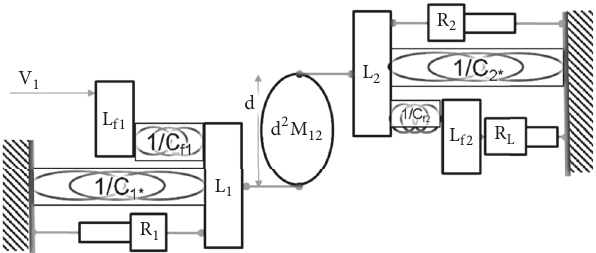
Figure 13: Equivalent 4-DOF mechanical system for the LCC